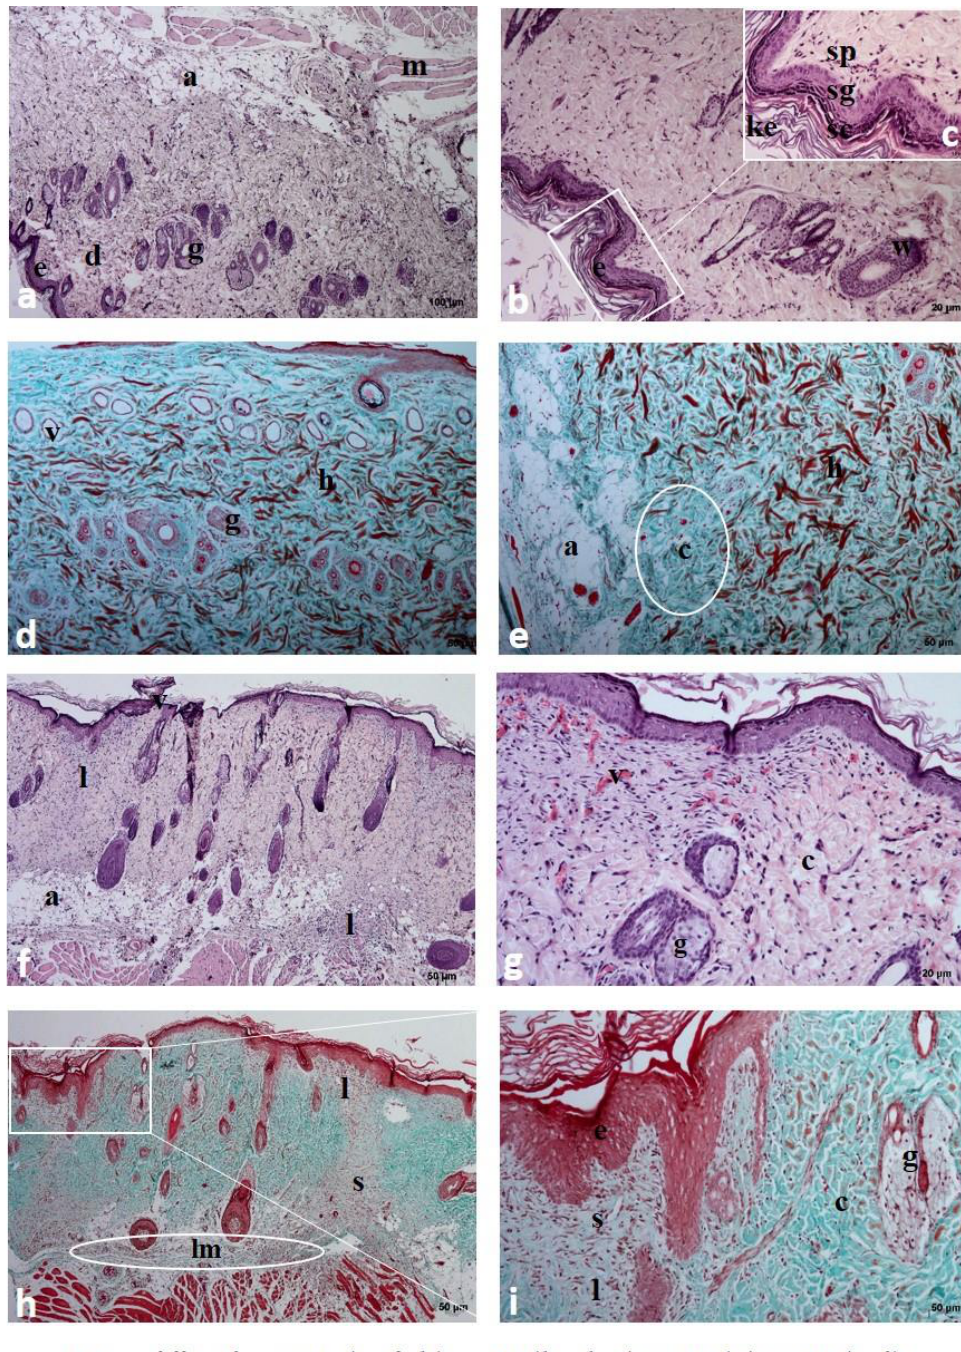
Figure 9. Histological examination of rat skin after the application of Spongostan ( a, b, c, d, e ) and placebo film (PVA/HPMC_B/C) ( f, g, h, i ) stained with hematoxylin and eosin (HE a, b, c, f, g ) and Masson’s trichrome ( d, e, h, i ) staining: e - epidermis; sc - stratum corneum; sg - stratum granulosum; sp - stratum spinosum; ke - keratin; d - dermis; h - hemorrhagic zones; a - adipose tissue; m - muscular cells; g - sebaceous gland; c - collagen fibers; lm - leukocytes and macrophages; s, ”scar.” In the subcutaneous part of rat skin after the application of placebo film ( h ), a visible layer of inflammatory cells (lm) and a zone with disturbed layers, structurally different from the surrounding, healthy tissues, were observed